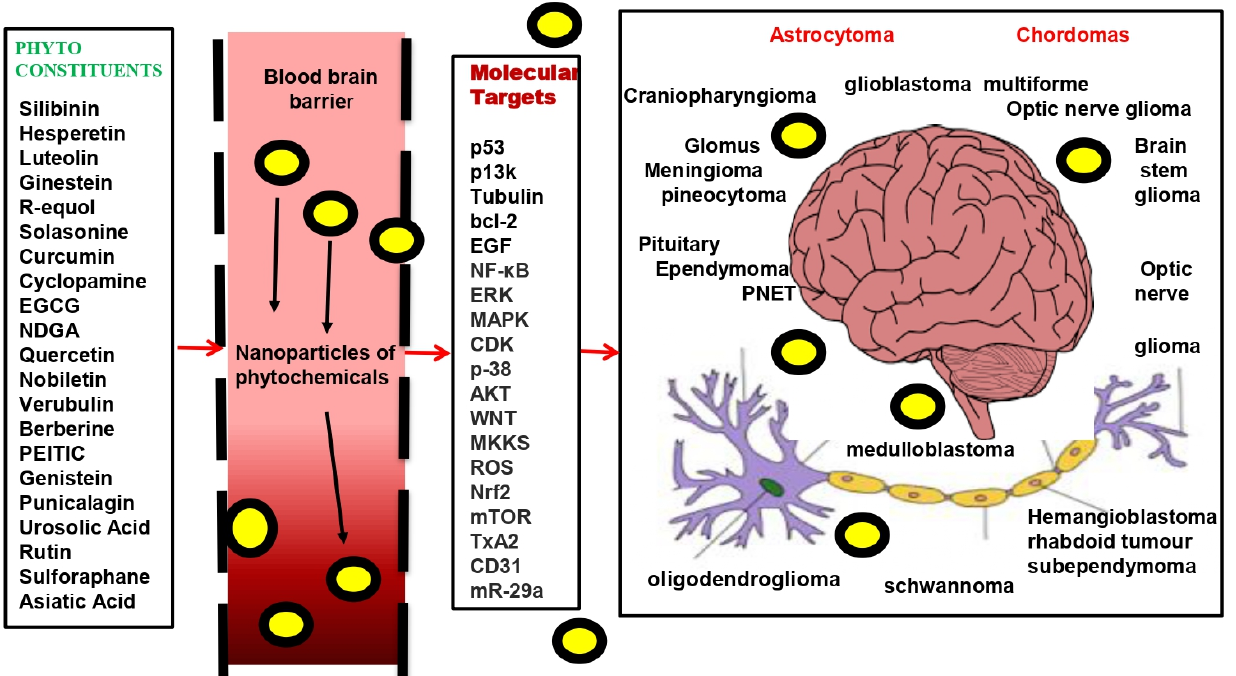
Figure 1. Phytochemical-encapsulated nanoparticle-based delivery to cross the BBB with increased absorption and stability to attack molecular targets in order to tackle various brain tumours. Phytochemicals that cannot cross the BBB are encapsulated in nanoparticles, which can improve the drug’s stability, absorption, and bioavailability. These nanoparticles modulate the molecular targets involved in different brain tumours (benign and malignant), as listed here.